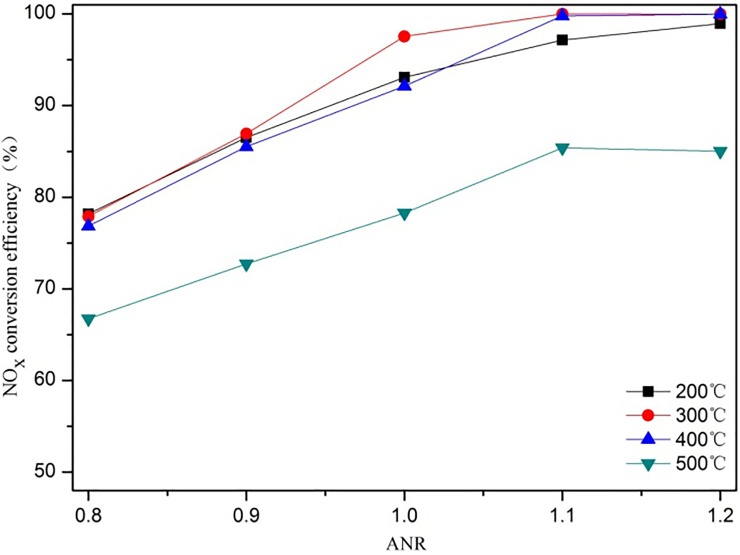
The effect of the ANR on the NOx conversion efficiency at NO2/NOx = 0.1.